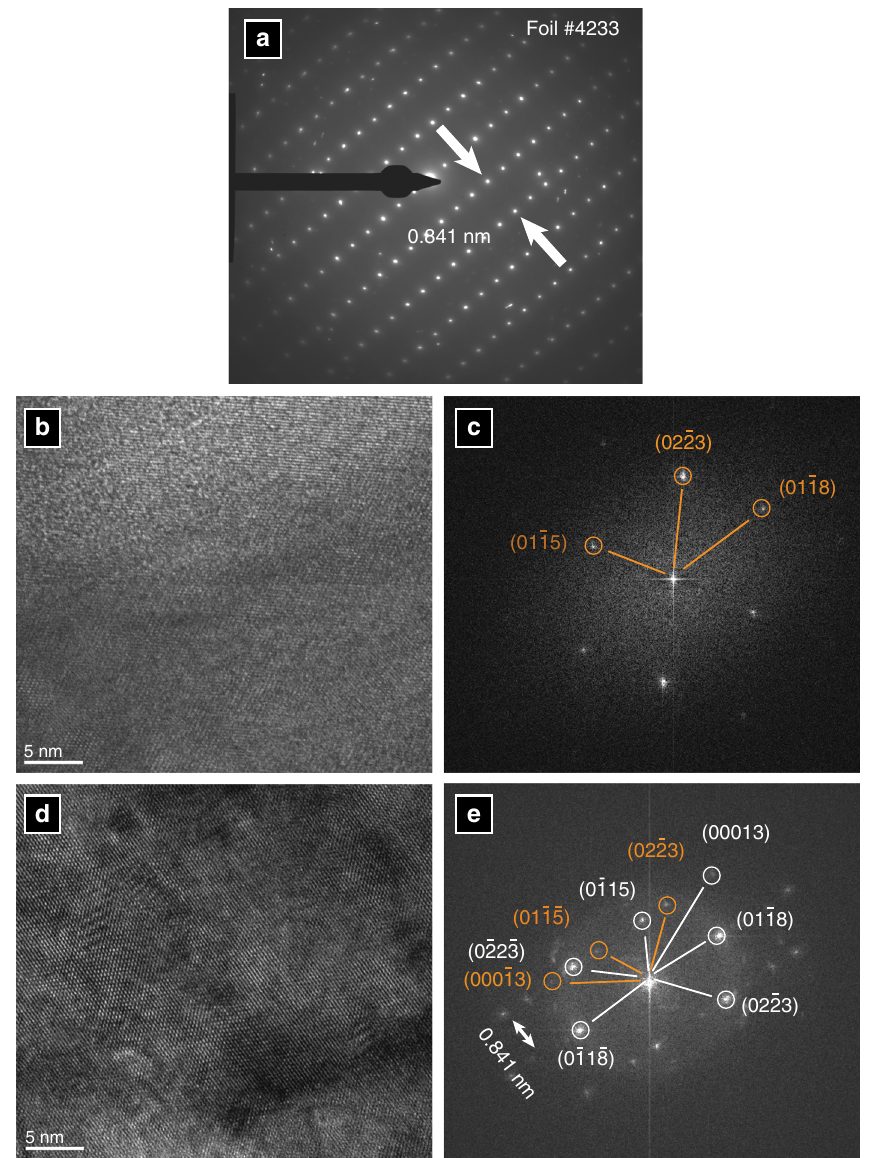
Fig. 3 Twinned structure of O. universa shells. Electron diffraction patterns collected from an entire TEM foil ( a ) show a prominent lattice spacing of 0.841 nm, which is consistent with neither calcite nor vaterite. High-resolution analysis of a crystallographically uniform region within the foil ( b ) via Fourier Analysis revealed a characteristic vaterite electron diffraction pattern ( c ; orange). Similar analysis of a crystallographically complex region within the superstructure ( d ) revealed that the 0.841 nm lattice spacing observed in the entire foil can be explained by a twinned vaterite structure, with twin pairs rotated 180 along the c -axis ( e ; orange vs. white). All analyses carried out in analytical session